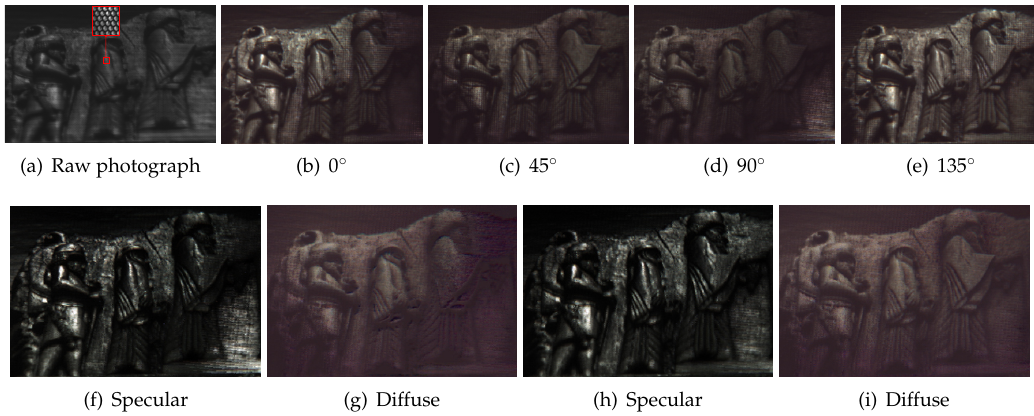
Figure 5. Single-shot separation of diffuse and specular reflectance under uncontrolled outdoor illumination (sunlight) using the proposed four-way polarized light-field (FPLF) camera. ( a ) A raw photograph of a piece of Persian relief taken with our FPLF camera. ( b – e ) Images sensed by rays travelling through each polarizer, which are generated by a single-shot light-field photograph. ( f , g ) Specular and diffuse albedo acquired by processing the three polarization images in ( b – d ). ( h , i ) Specular and diffuse albedo acquired by processing the four polarization images in ( b – e